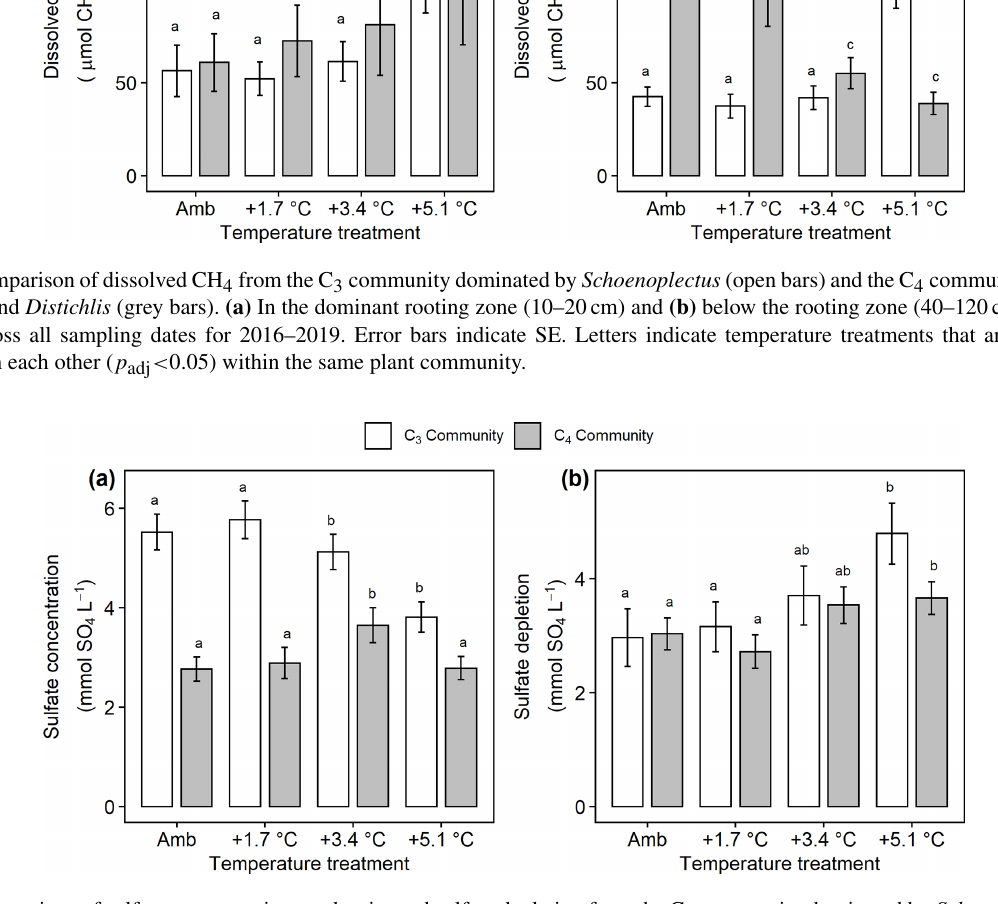
Figure 6. Comparison of sulfate concentrations and estimated sulfate depletion from the C 3 community dominated by Schoenoplectus (open bars) and the C 4 community dominated by Spartina and Distichlis (grey bars). (a) Sulfate availability throughout the entire soil profile and (b) sulfate depletion in the rooting zone. Means are averaged across all sampling dates for 2016–2019. Error bars indicate SE. Letters indicate temperature treatments that are significantly different from each other ( p adj < 0 . 05) within the same plant